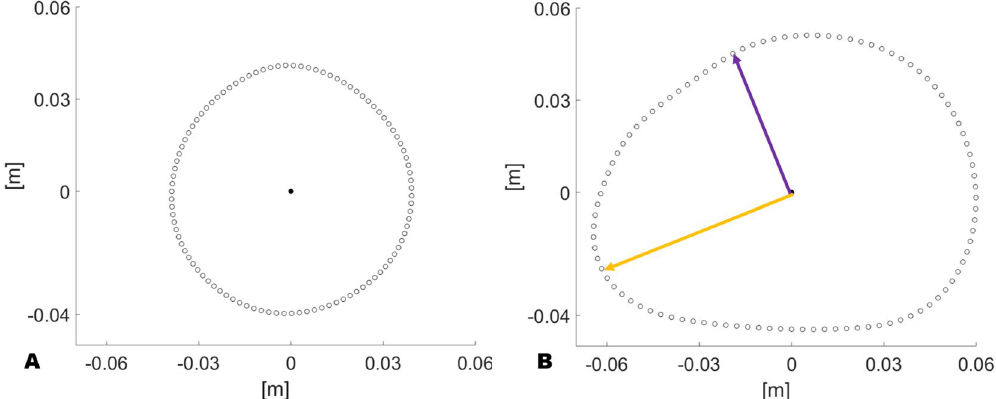
Figure 3. Comparison of the computed chest boundaries which feature the minimum ( A ) and the maximum ( B ) value of shape function. The purple arrow indicates the minimum distance from the centroid, whilst the orange one is the maximum